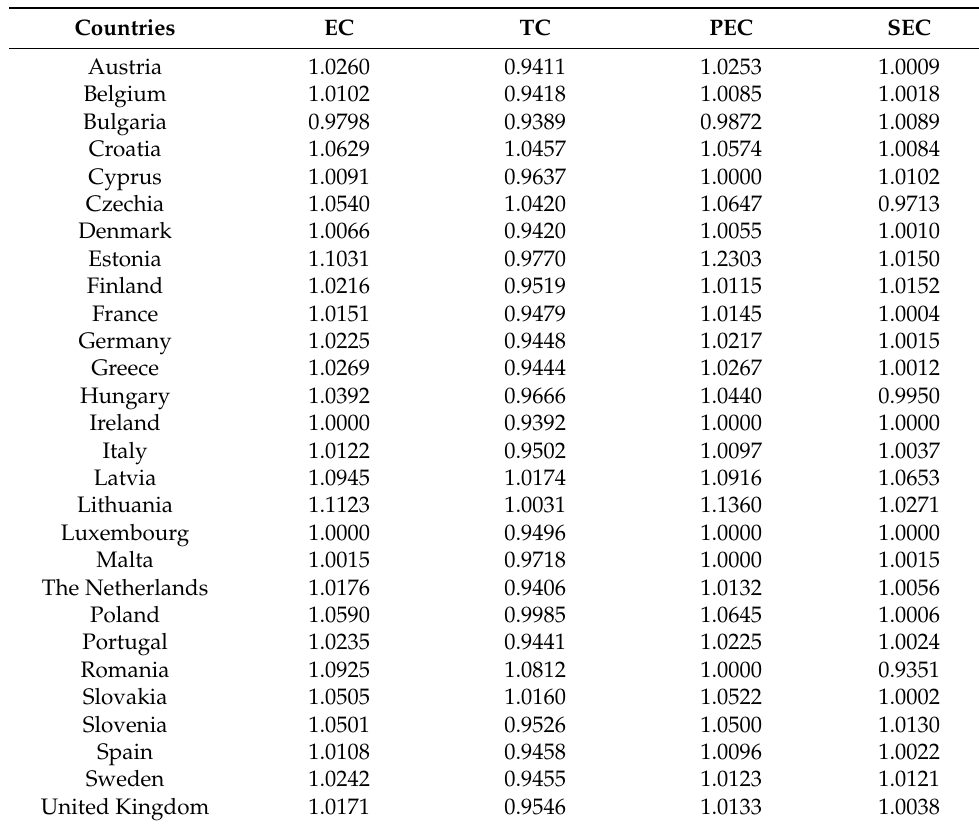
Table A1. Annual means, for the entire period, of Malmquist productivity index components by country.